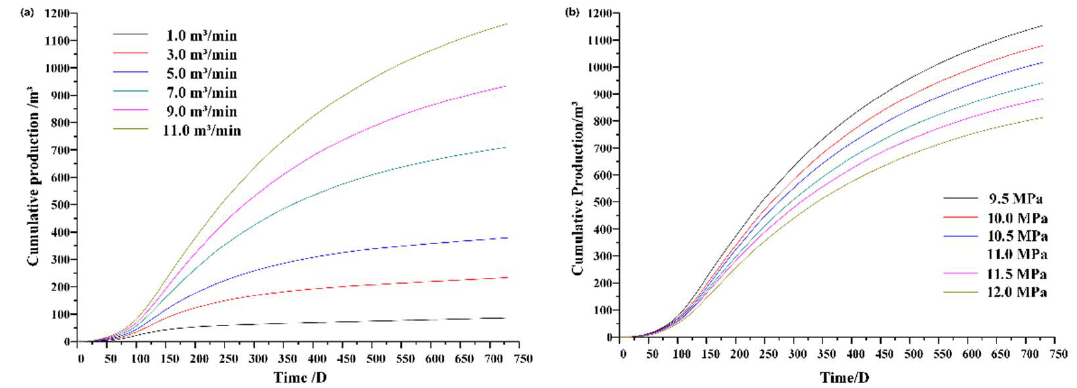
Figure 10. Influence of mining flow rates and pressure on cumulative productivity. ( a ) Different injection flow ( b ) Different injection pressure